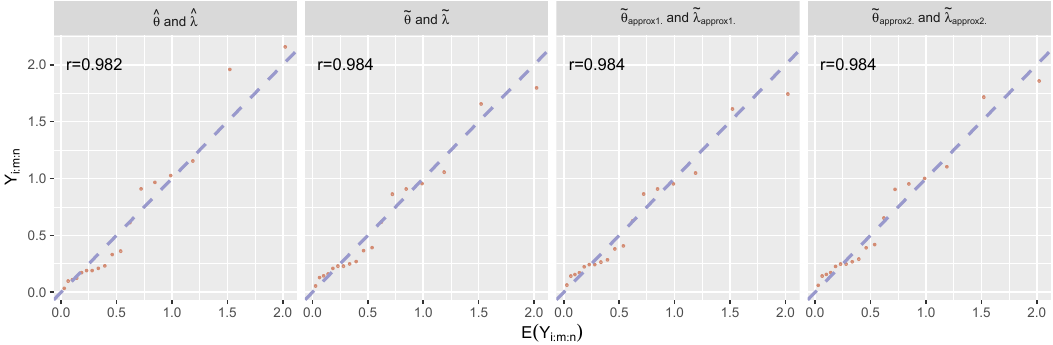
Figure 4. The scatter plots between Y i : m : n and E ( Y i : m : n )